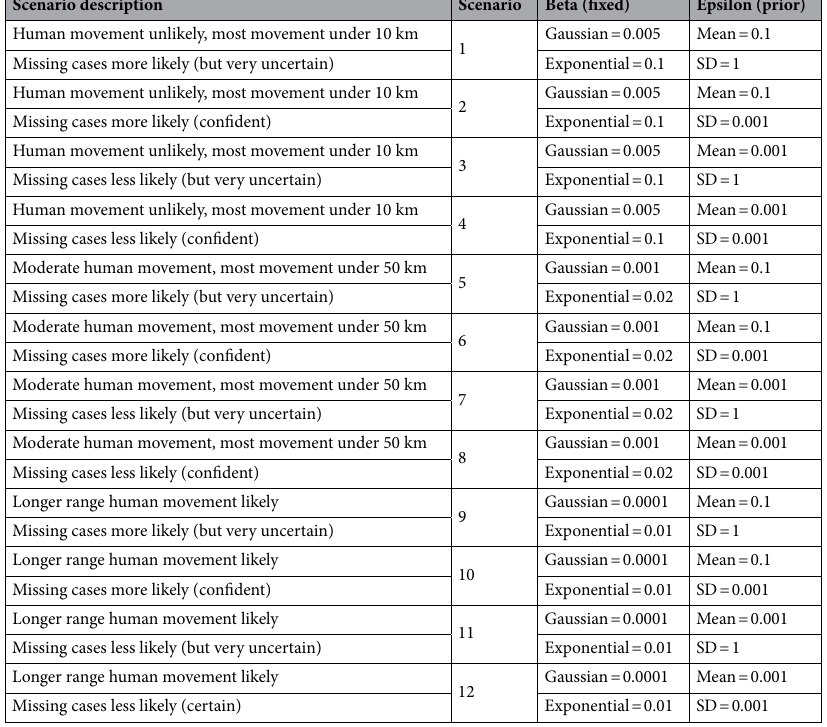
Table 1. Illustrating the different scenarios and corresponding parameter values tested in scenario analysis.